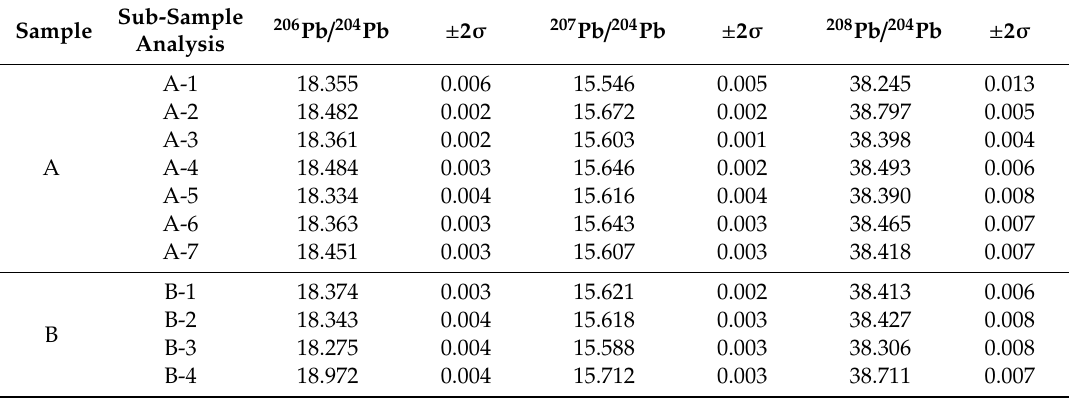
Table 3. Sulfur isotope data for the pyrites in this study.